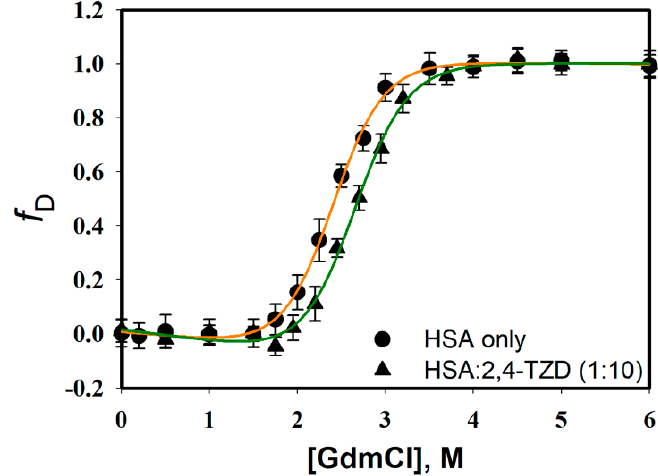
Figure 7. GdmCl-induced denaturation of HSA in the absence or presence of 2,4-TZD. n = 3.